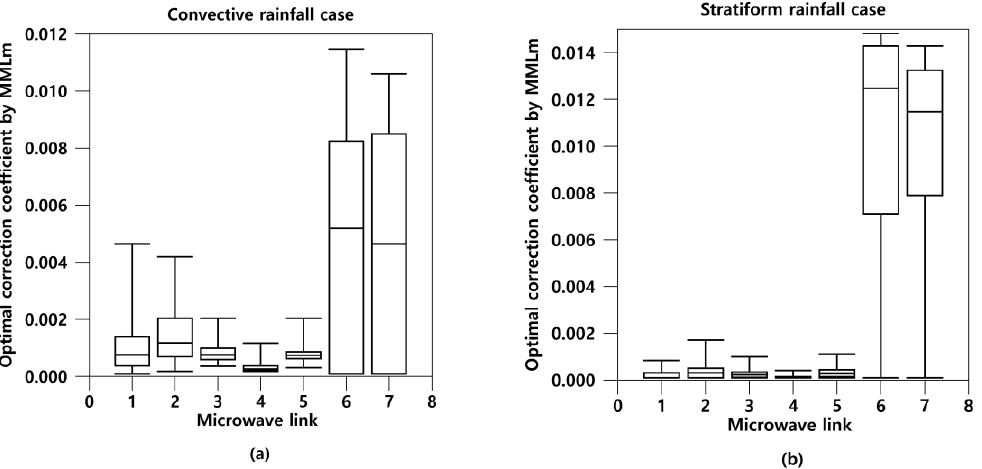
Figure 9. Box-whisker plots of time-varying optimized attenuation correction coefficients, a , with each individual microwave link determined by MMLm during ( a ) the convective rainfall case and ( b ) the stratiform rainfall case.